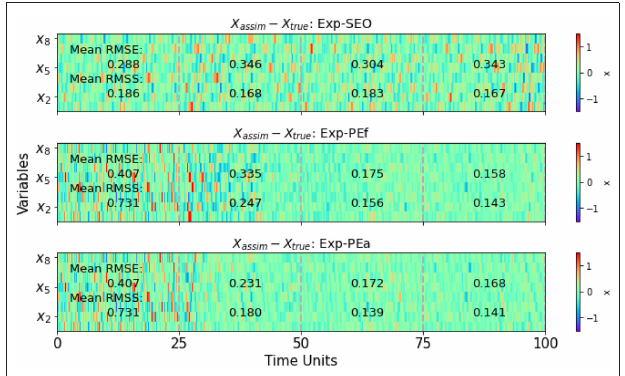
FIGURE 2 | The errors of the assimilated ensemble mean against the true values for Exp-SEO (A) , Exp-PEf (B) , and Exp-PEa (C) .